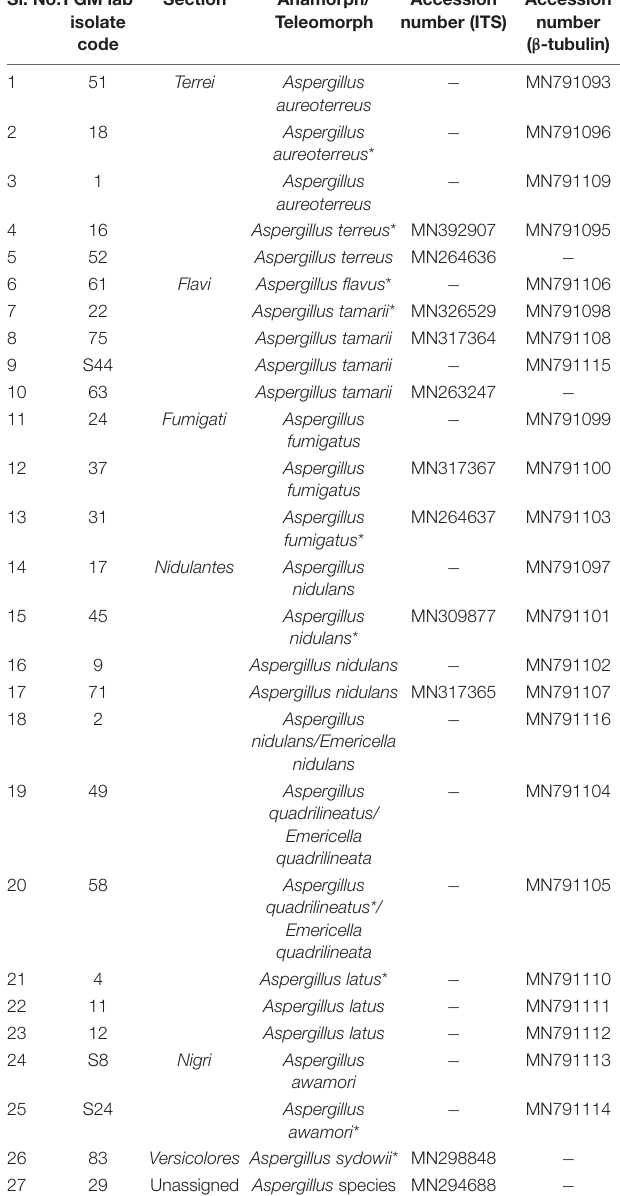
TABLE 1 | Section-wise details of Aspergillus isolates used in the current study, GenBank accession numbers of ITS and β -tubulin gene